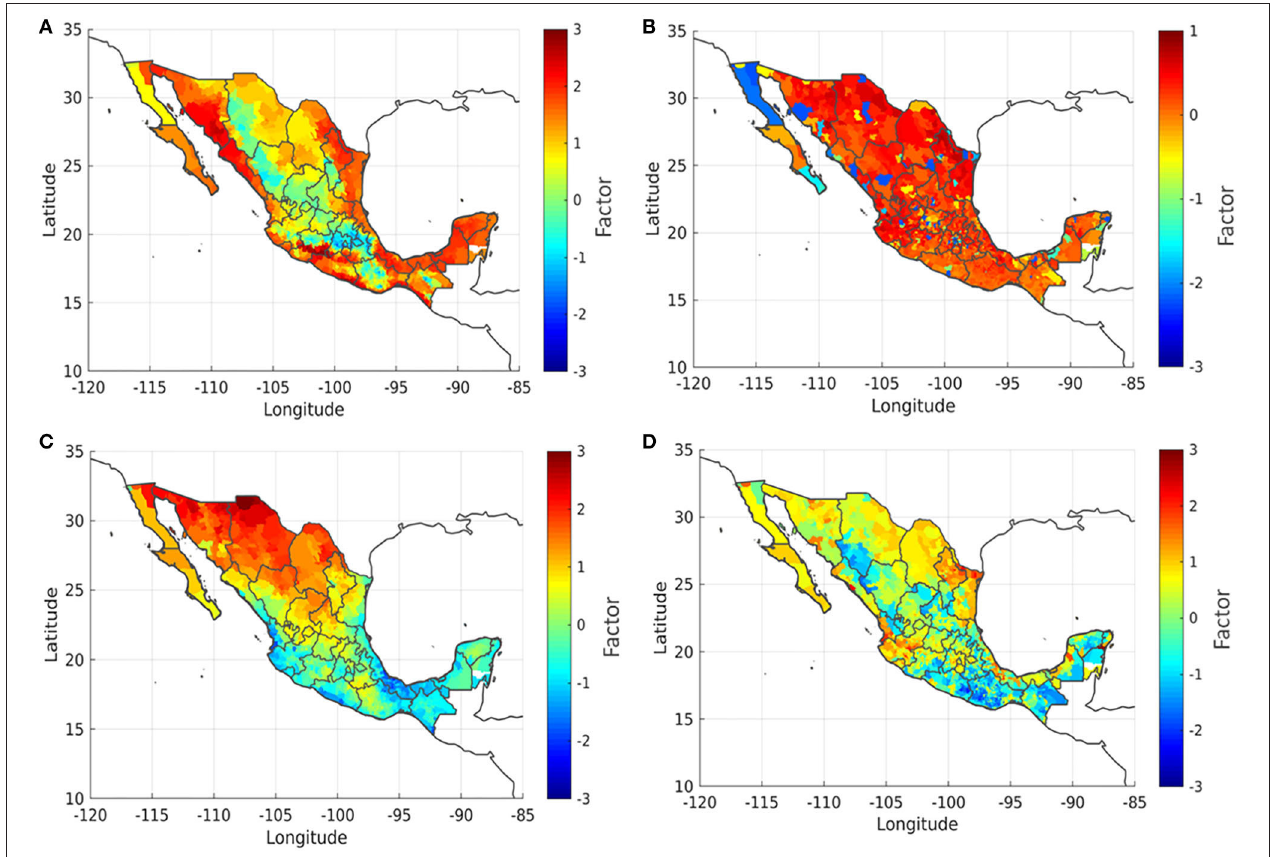
FIGURE 2 | Climatic and Socio-economic factors regionalization. (A) Combination of variables related to temperature, (B) Combination of Population and GDP size, (C) Combination of temperature variables, precipitation, and rainfed maize yield, (D) Combination of Index of marginalization, people working on the primary sector and per capita GDP.